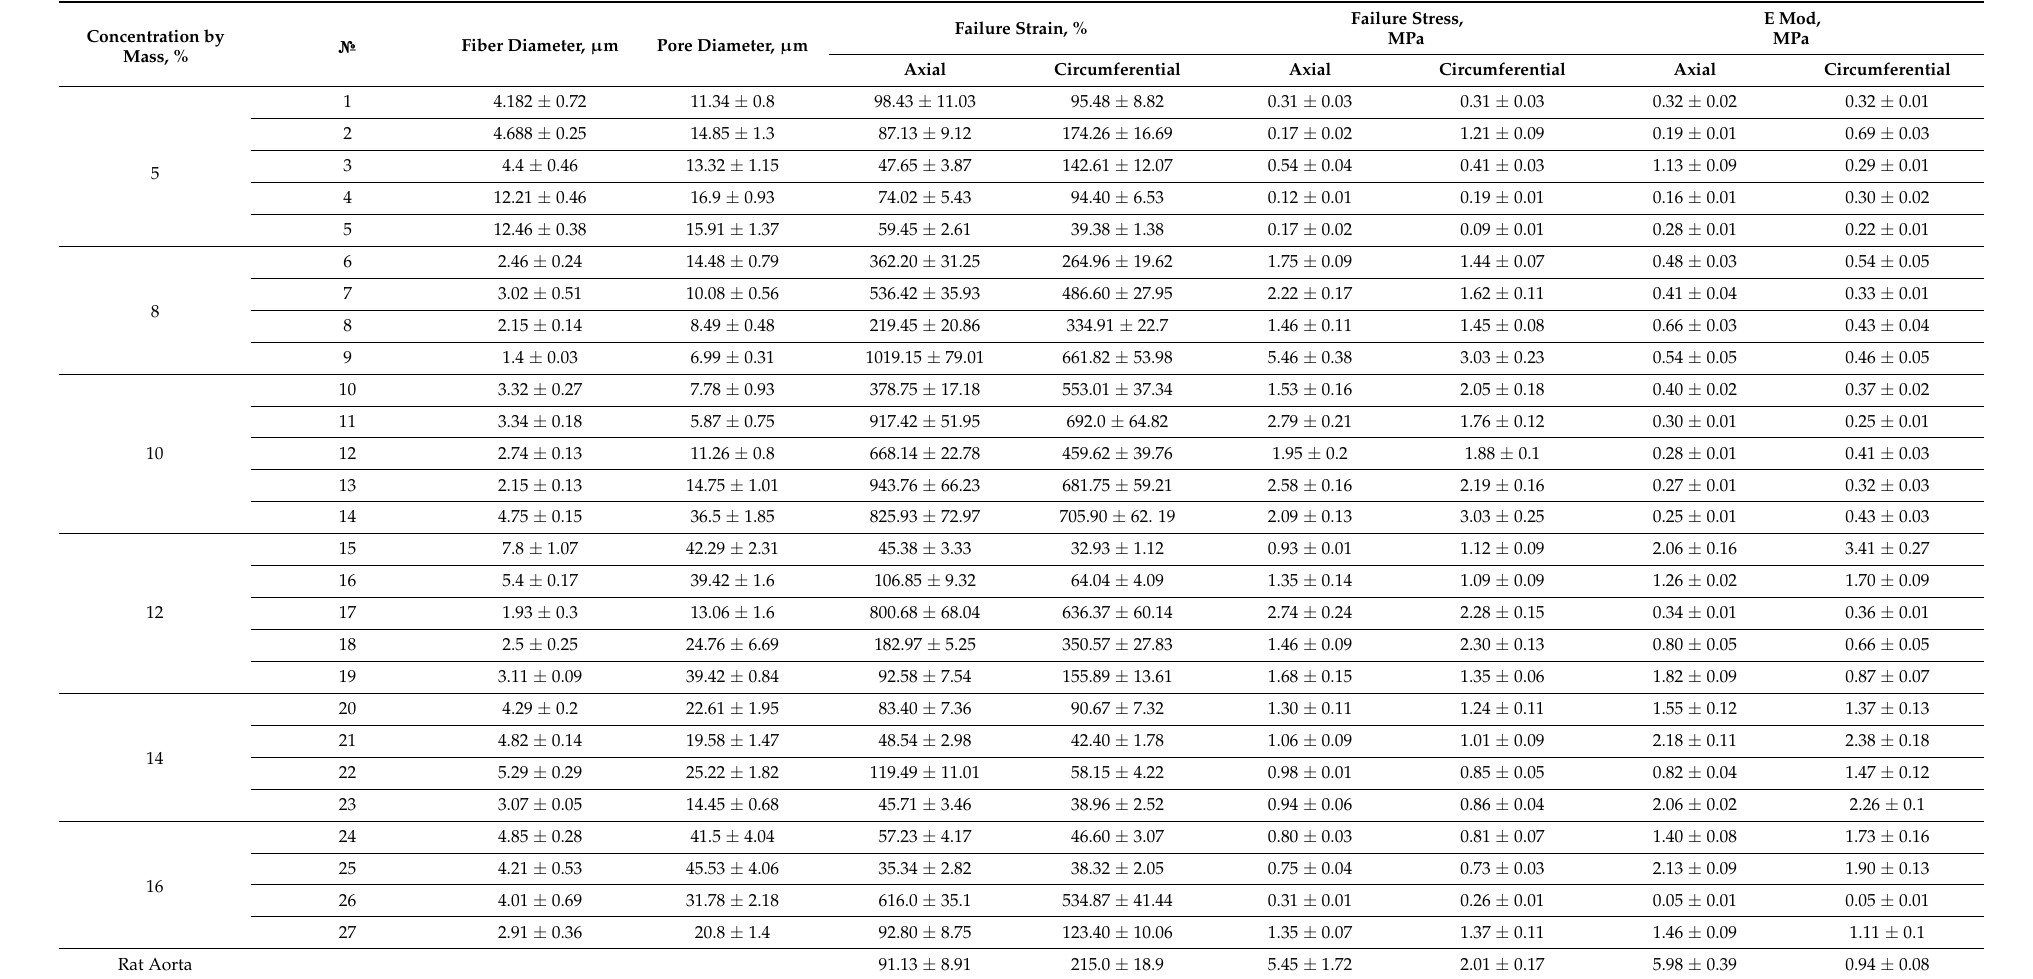
Table 2. Structural and biomechanical characteristics of obtained PCL